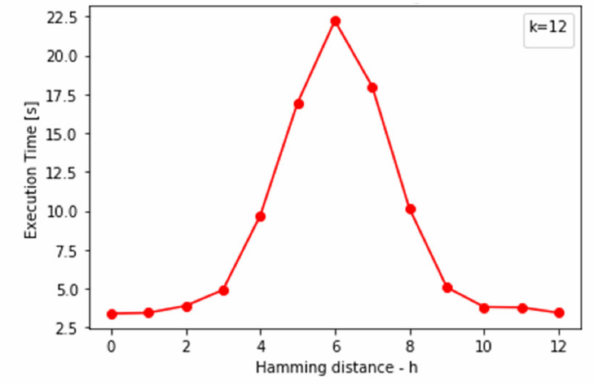
Figure 17. Execution time of the locking algorithm against k